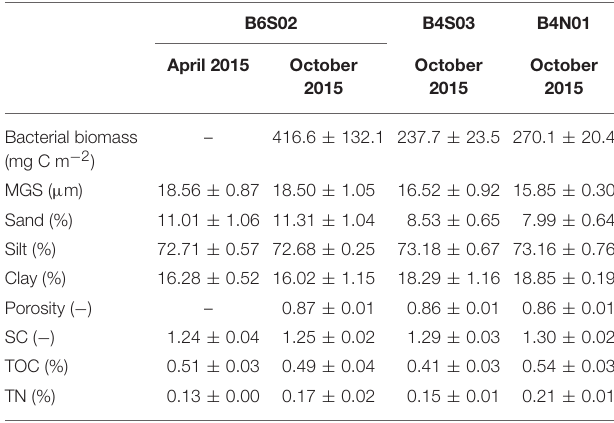
TABLE 2 | Average ( ± SD ) sediment-depth integrated (0-5 cm) environmental variables per site sampled in the GSR license area during GSRNOD15A